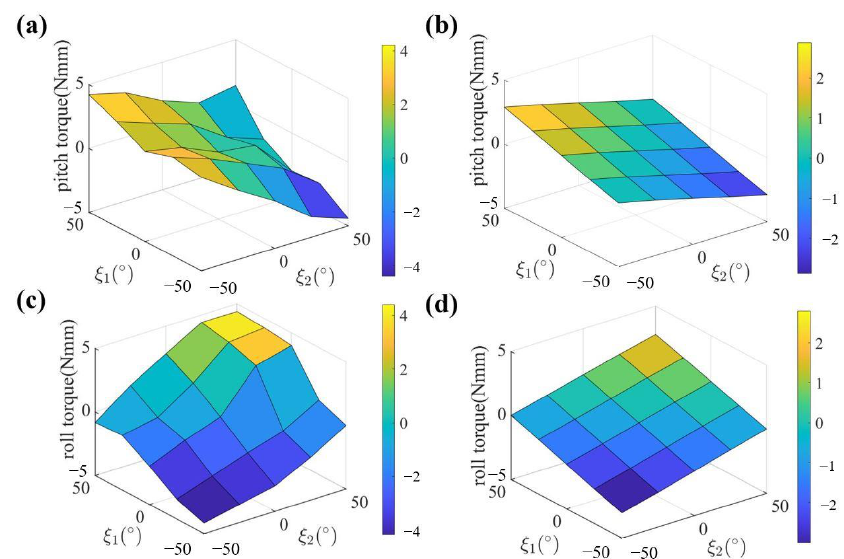
Figure 19. The control torque at different servo angle input. ( a ) The measured total pitch control. ( b ) The calculated pitch control produced by stroke plane rotation. ( c ) The measured total roll control. ( d ) The calculated roll control produced by stroke plane rotation.